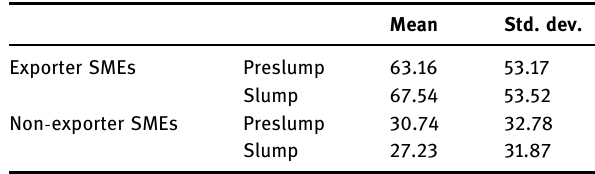
Table 3: Employment for exporter and nonexporter SMEs during the preslump and slump periods